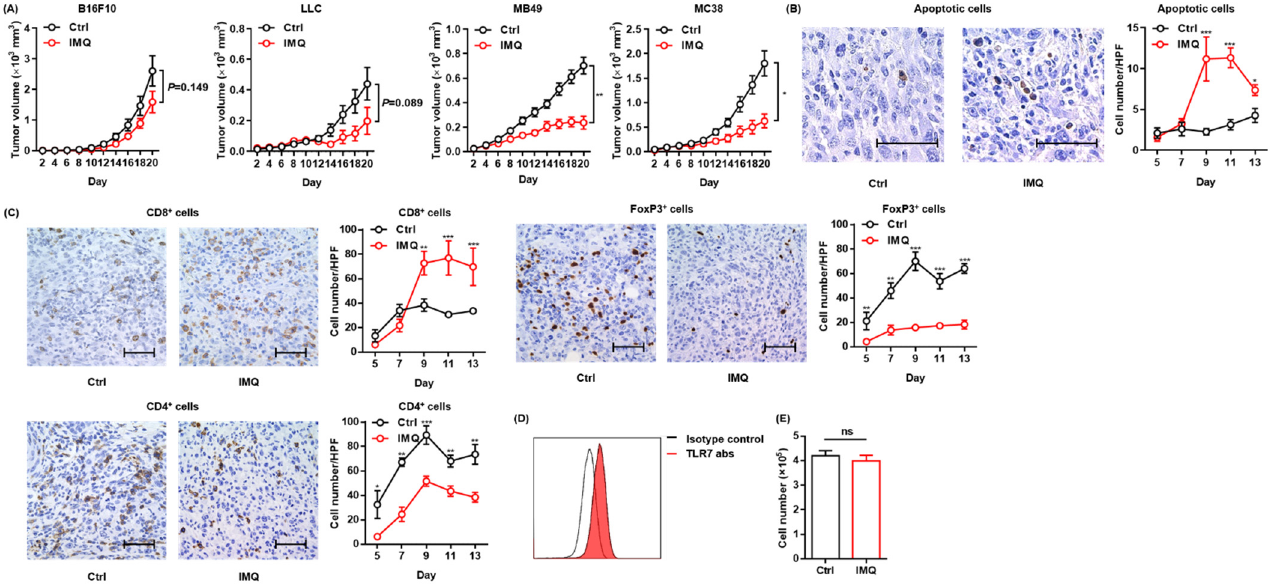
Figure 1. Topical IMQ exerts an antitumor effect through the enhancement of the immune response to MC38 colon cancer. ( A ) Time course of the tumor volume after 3 × 10 5 B16F10 melanoma cells, 1 × 10 6 LLC cells, MB49 bladder cancer cells, or 2 × 10 6 MC38 colon cancer cells were intradermally inoculated into the backs of wildtype mice. IMQ was topically applied to the back over the tumor every other day from day 2 to day 18, and untreated mice were used as the control ( n = 10 [B16F10] and 6 [LLC, MB49, and MC38] in each group). ( B , C ) Representative histopathology of apoptosis staining ( B ) or immunohistochemical staining ( C ) at day 9, and the number of apoptotic tumor cells ( B ) and the number of CD8 + T cells, CD4 + T cells, and Foxp3 + cells ( C ) in the tumor at each indicated day after the inoculation of MC38 cells into wildtype mice, quantified in 5 randomly selected high-power field (HPF) images per mouse ( n = 6 in each group of days 5 and 7, and n = 7 in each group of days 9, 11, and 13, respectively. Bar = 50 µ m). ( D ) Representative flow cytometric analysis of TLR7 expression in MC38 in vitro. ( E ) The number of living MC38 cells stimulated with IMQ or the control for 3 days in vitro (n = 6 in each group). Ctrl: control, IMQ: imiquimod, HPF: high-power (400 × ) field, abs: antibodies, ns: not significant. Error bars indicate ± 1 SEM; * p < 0.05, ** p < 0.01, *** p < 0.001.